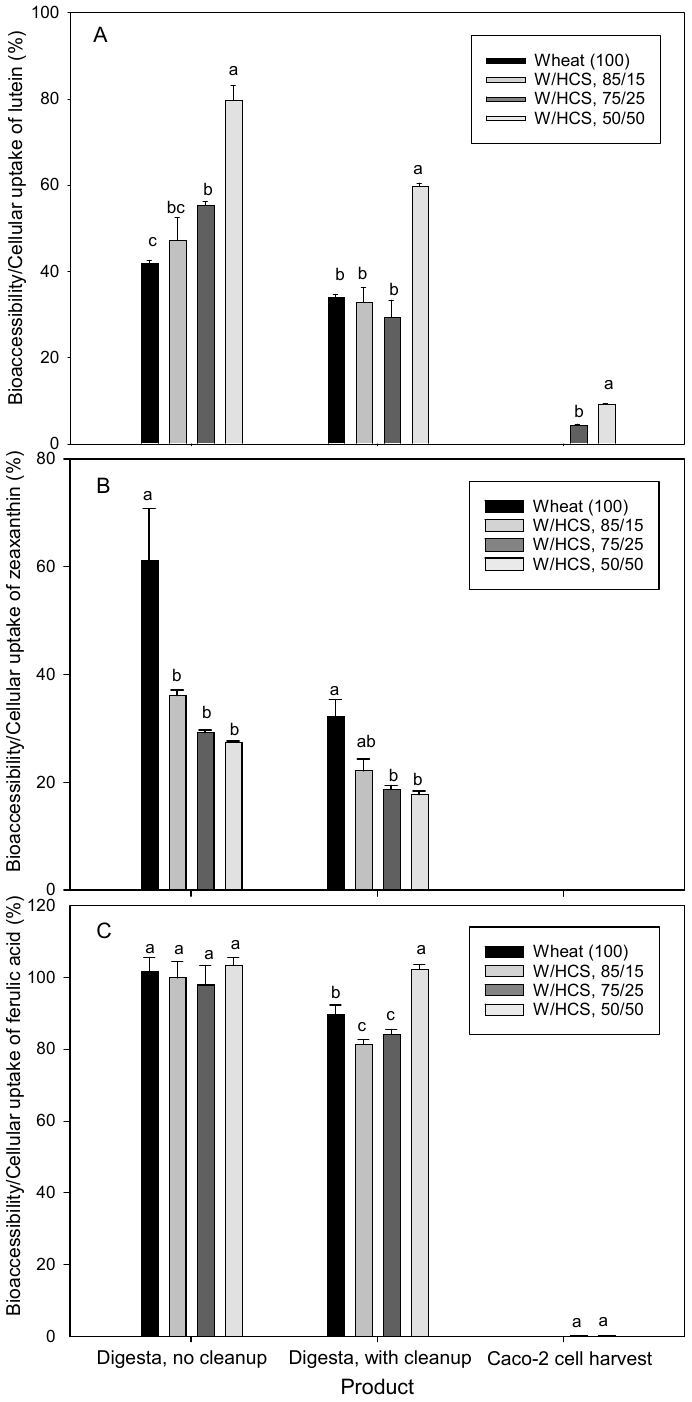
Figure 1. In vitro bioaccessibility of lutein from muffin intestinal digests without cleanup ( A ) and with cleanup ( B ) and its Caco-2 cellular uptake ( C ). Bars with the same letter are not significantly different at p <